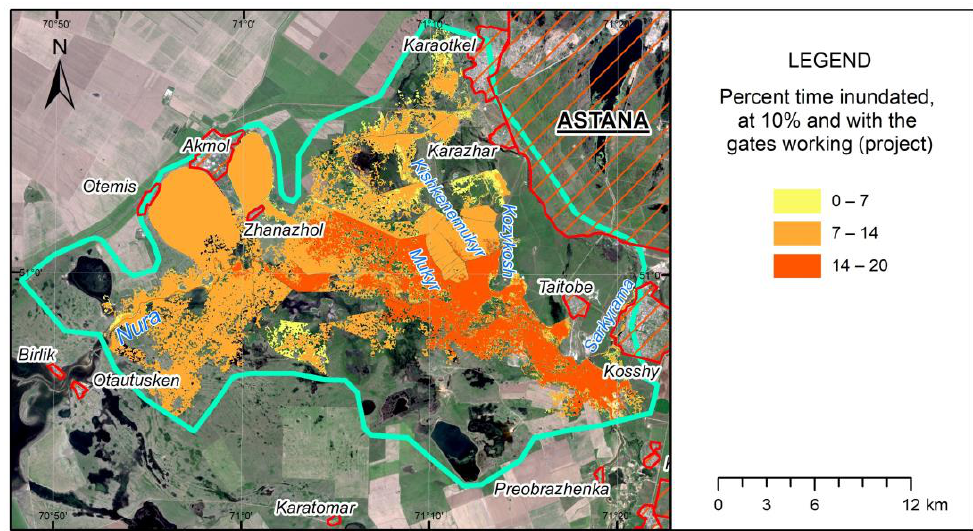
Figure 14. Maximum flood depth map of the 2019 flood hydrograph simulated on modified DEM.